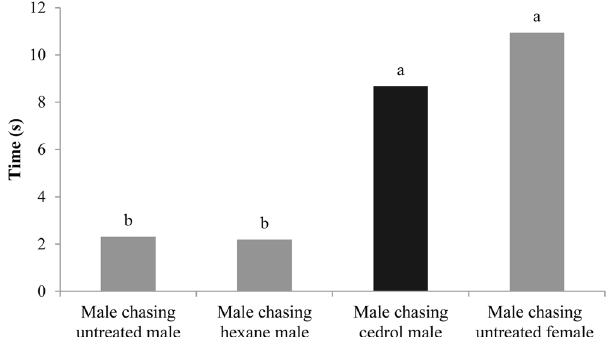
Figure 6. The average single chase time in experiments to assess the effect of cedrol. hexane male: male with wings painted with hexane; cedrol male: male with wings painted with cedrol. Different letters above bars indicate significantly different at P < 0.05 significance